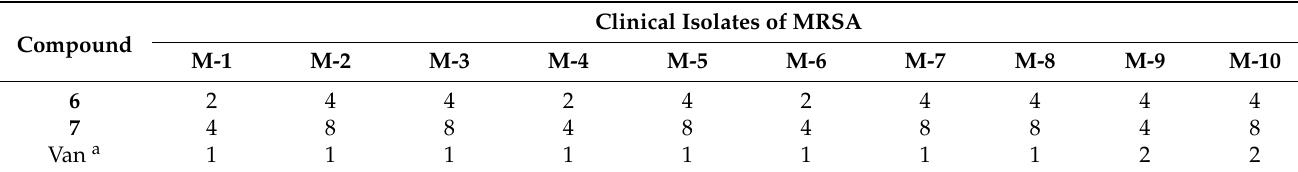
Table 4. MIC (μg/mL) values of compounds 6 and 7 against clinical MRSA strains in vitro . Table 4. MIC ( µ g/mL) values of compounds 6 and 7 against clinical MRSA strains in vitro. Compound Clinical Isolates of MRSA Compound